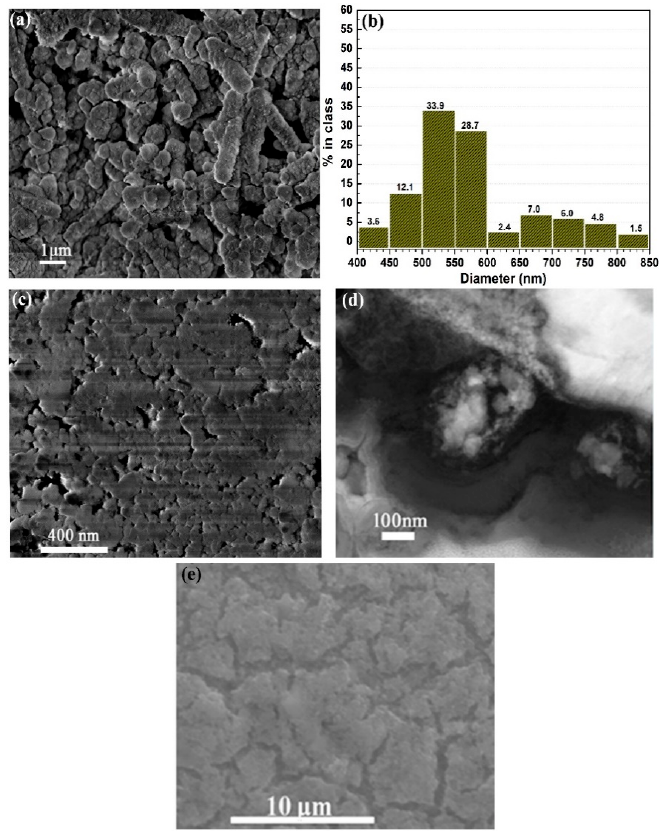
Figure 6. ( a , b ) SEM image and corresponding diameter distribution of the Cu@Si CSNWFs after 30 cycles; ( c , d ) SEM image and cross-section STEM image of the Cu@Si CSNWFs after 500 cycles; and ( e ) SEM image of the pure Si film after 20 cycles at a current rate of 0.1 C between 0.01 and 1.5 V.